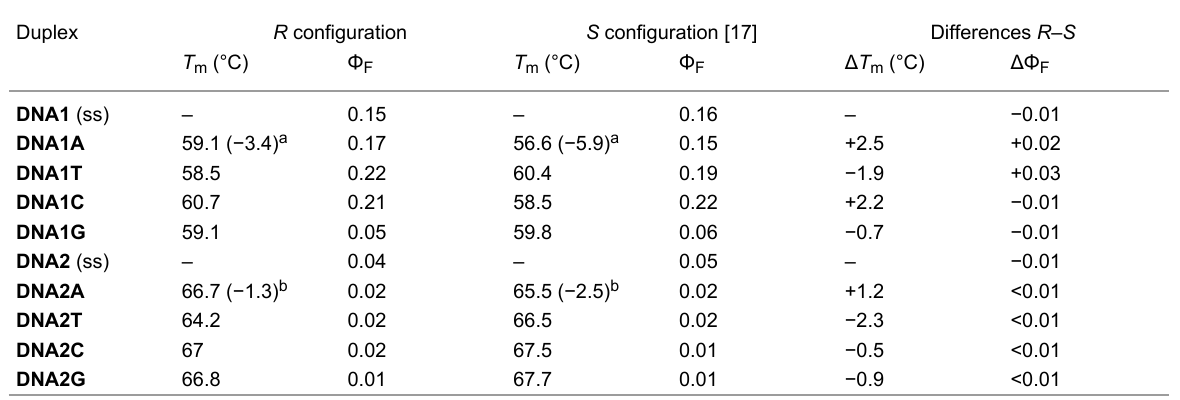
Table 1: Melting temperatures ( T m ) and quantum yields (Φ F ) of duplex sets DNA1Y and DNA2Y bearing the R -configured linker in comparison to the corresponding values with the S -configured linker [17].